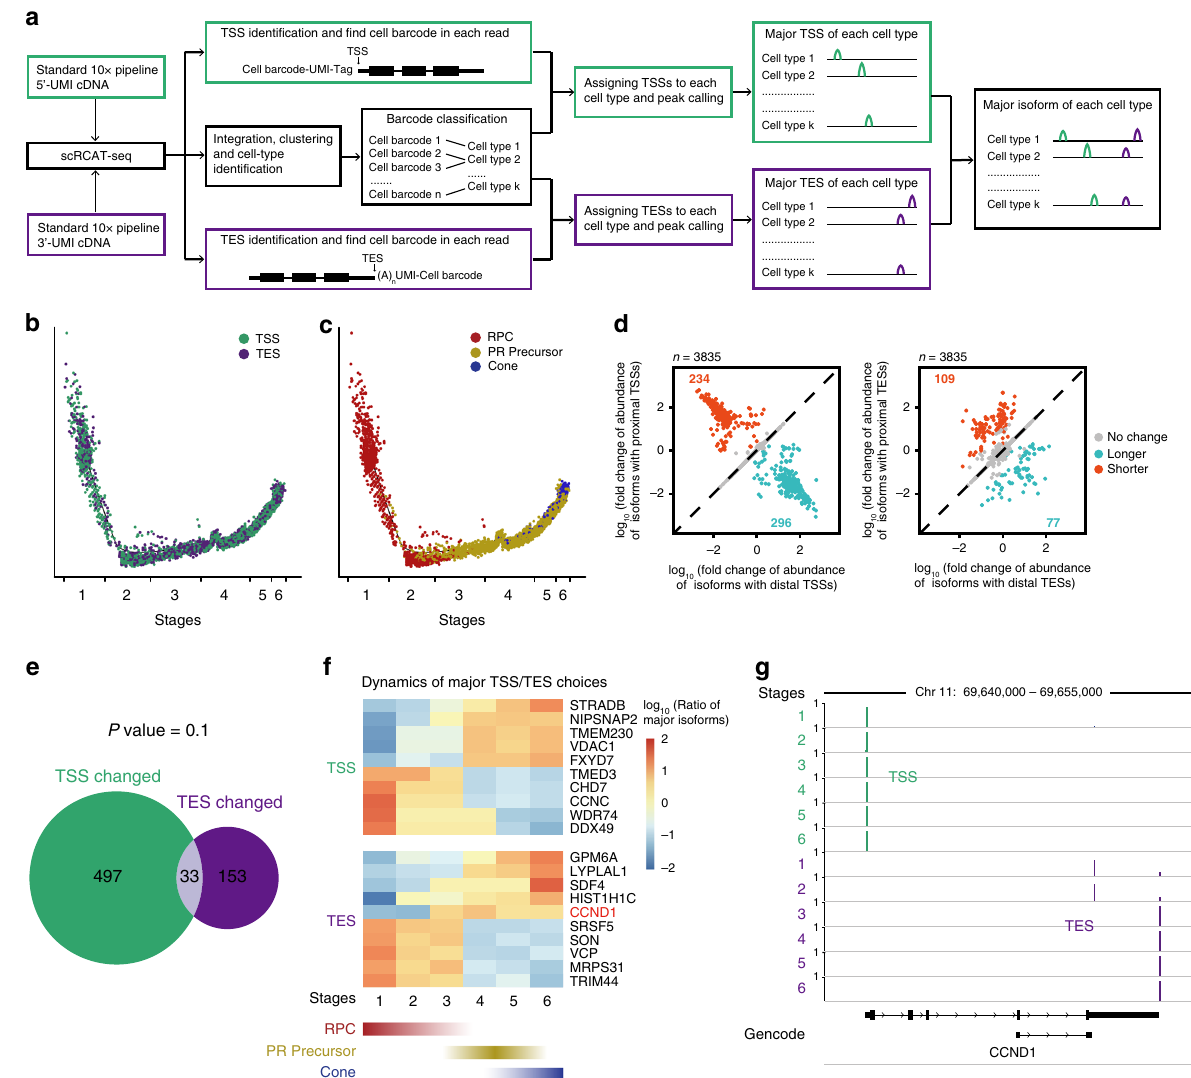
Fig. 4 Isoform dynamics during human cone development. a Outline of the high-throughput scRCAT-seq. b Trajectory plot showing the distribution of TES and TSS data on the trajectory of cone development. Each dot represents a single cell, either from TSS or TES data. c Trajectory for the development of cone from RPC generated by using pseudotime analysis with RPC, PR precursor, and photoreceptor cone data. The numbers below show the trajectory divided into stages, to assess the isoform dynamics. d Expression data with isoform speci fi city reveals differential TSS choices (left) and TES choices (right) between cone and RPC. e Venn diagram of genes with alternative TSSs and with alternative TESs. Signi fi cance was computed using two-sided hypergeometric test. f Dynamics of the ratio of major isoforms during the development of cones from RPC. Examples of isoforms with signi fi cant differential choices of TSS/TES between RPC and cone are shown, with dynamics for TSS and TES choices in upper and lower panel respectively. The color shows the logNormalized ratio of major isoforms of RPC in each stage. g Genome browser track showing the representative gene CCND1 , where two isoforms differ by a switched TES choice over the time course of cone development. Source data are provided as a Source data fi